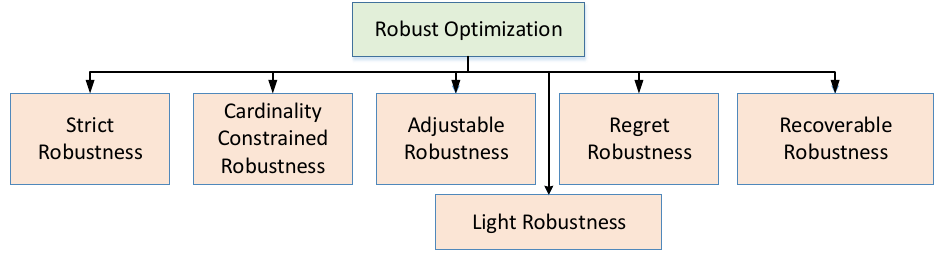
Figure 4. Taxonomy of robust